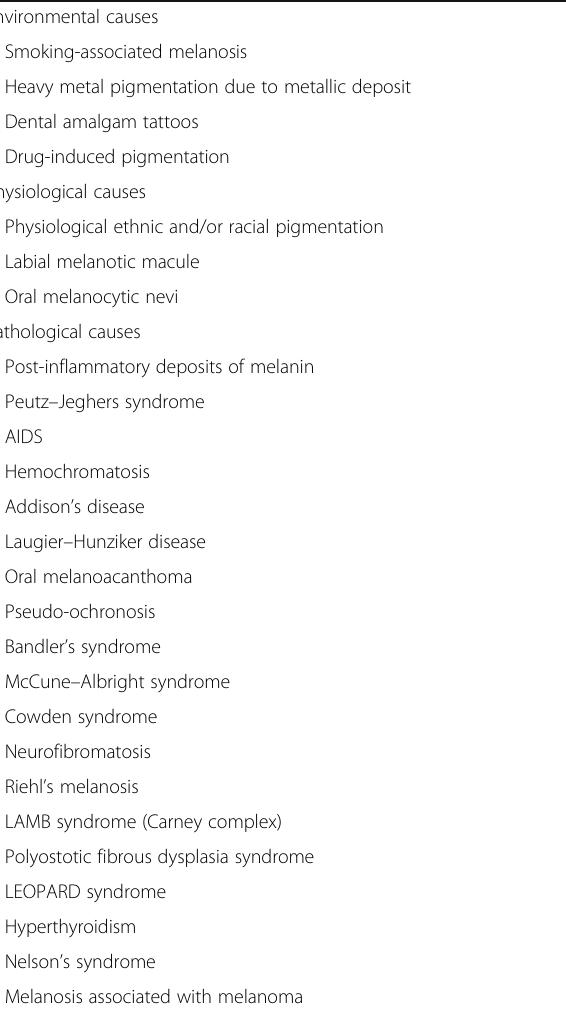
Table 1 Conditions associated with mucosal pigmentation that should be considered during the differential diagnosis of